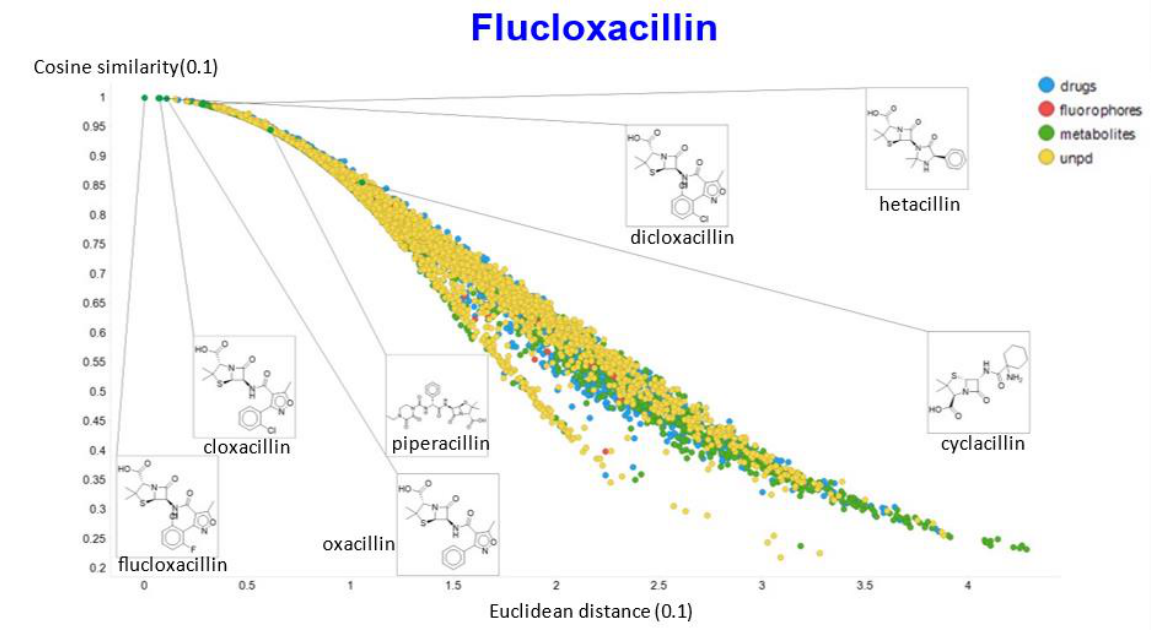
Figure 15. Relationship between cosine similarity and Euclidean distance for flucloxacillin in our chemical space, with a temperature parameter of 0.1.